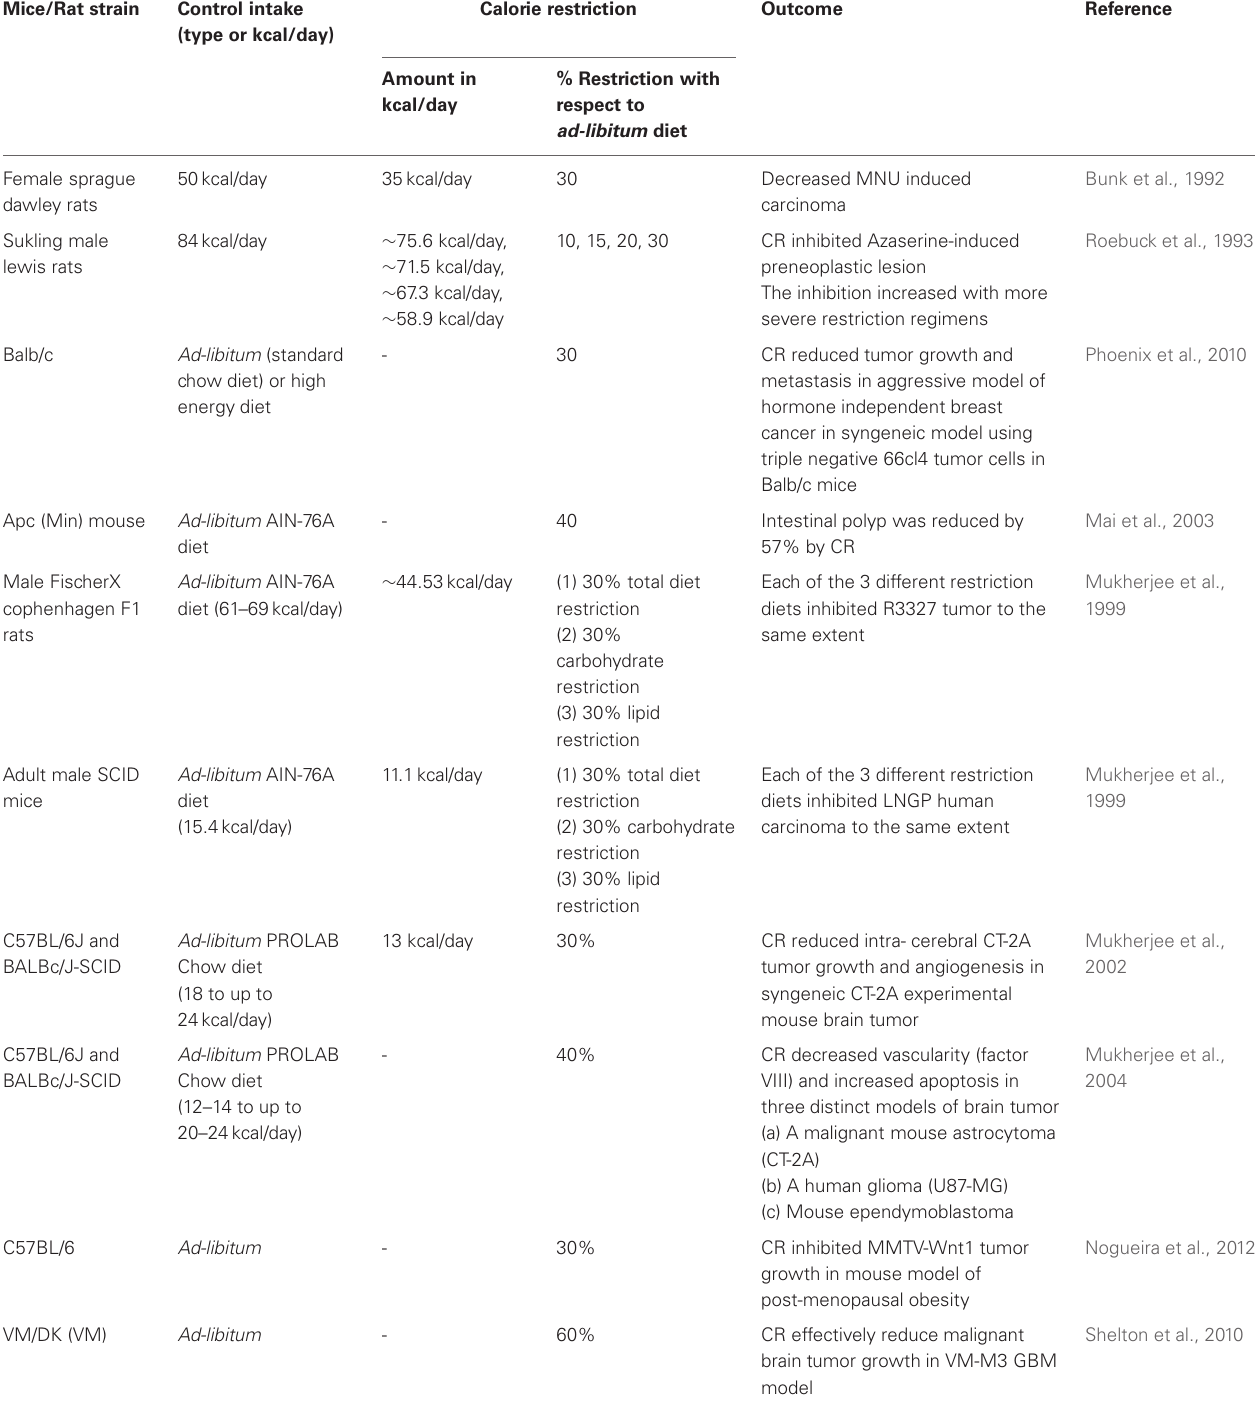
Table 1 | Summary of the extent of caloric restriction and its effect on tumor growth. Mice/Rat